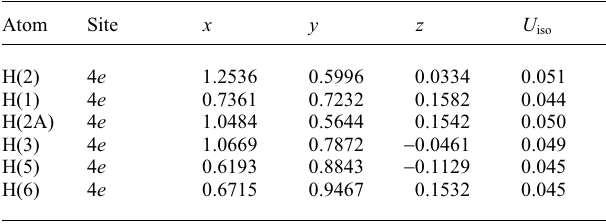
Table 2. Atomic coordinates and displacement parameters (in Å 2 )